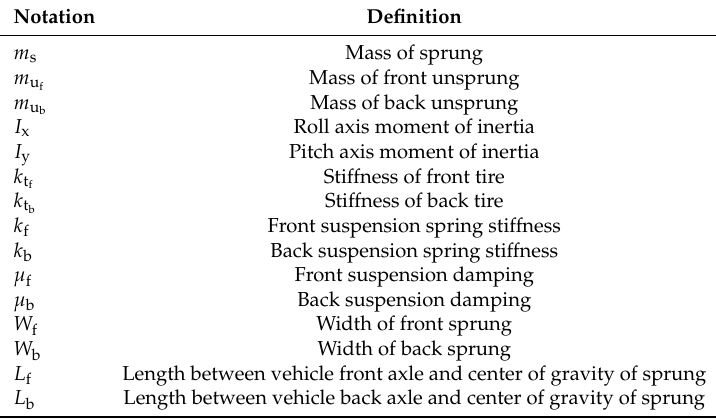
Figure 4. The models of vehicle suspension systems. Table 2. The definitions of the constants used in the vehicle suspension